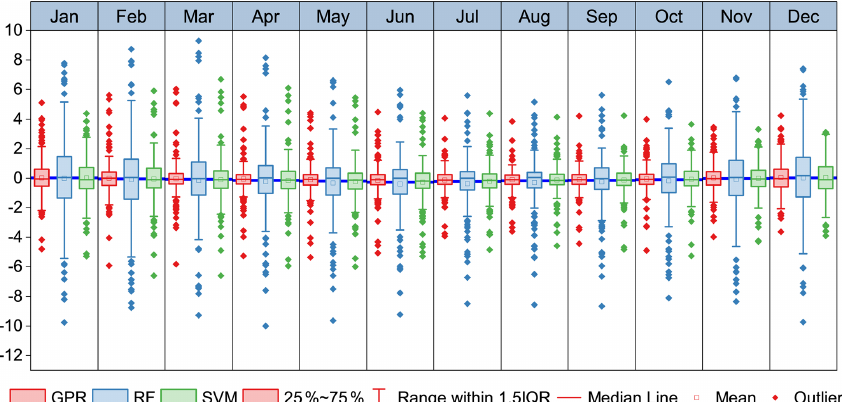
Figure 4. Residuals of the monthly Tmean predicted by the machine learning models with respect to in situ Tmean for the test meteorological stations. Note that the average of the residuals of Tmean from 1951–2020 for each test meteorological station is shown for each month. See Figs. S6 and S7 for the residual graph of Tmax and